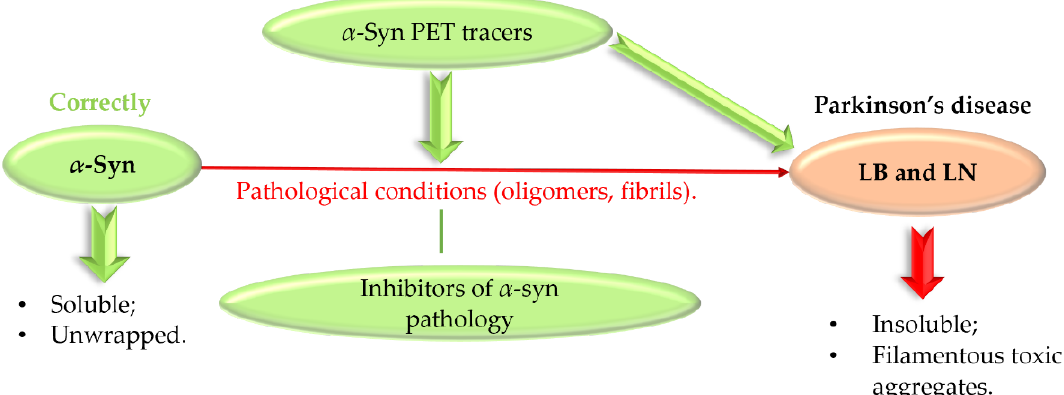
Figure 23. Formation of insoluble α -synuclein aggregates and a role of α -synuclein PET tracers and inhibitors. PET — positron emission tomography, LB — Lewy bodies, LN — Lewy neurites.